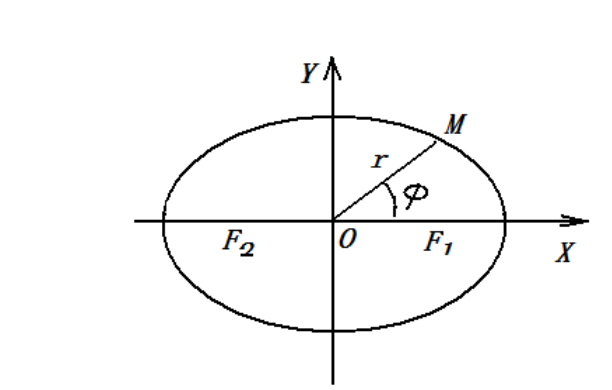
Fig. 1 – Polar coordinate of the elliptical current-carrying ring Рис. 1 – Полярные координаты эллиптического скользящего кольца Слика 1 – Поларне координате елиптичног клизног